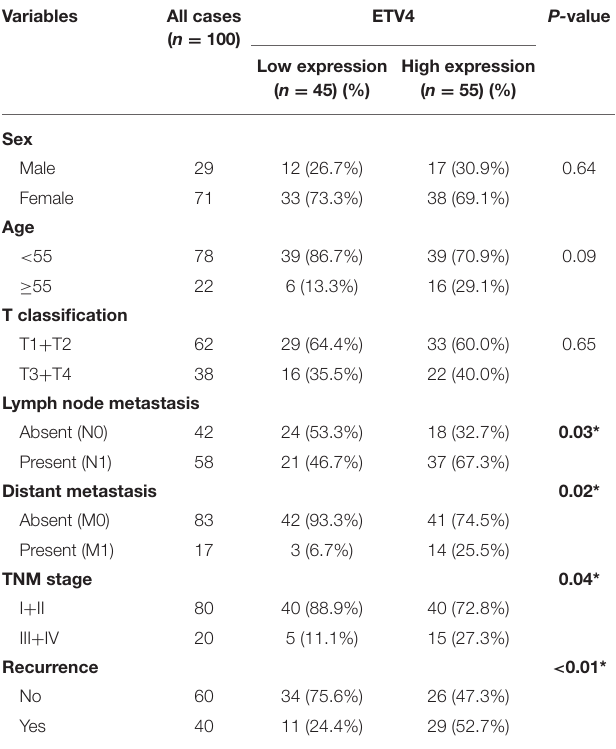
TABLE 1 | The clinicopathological parameters in 100 PTC